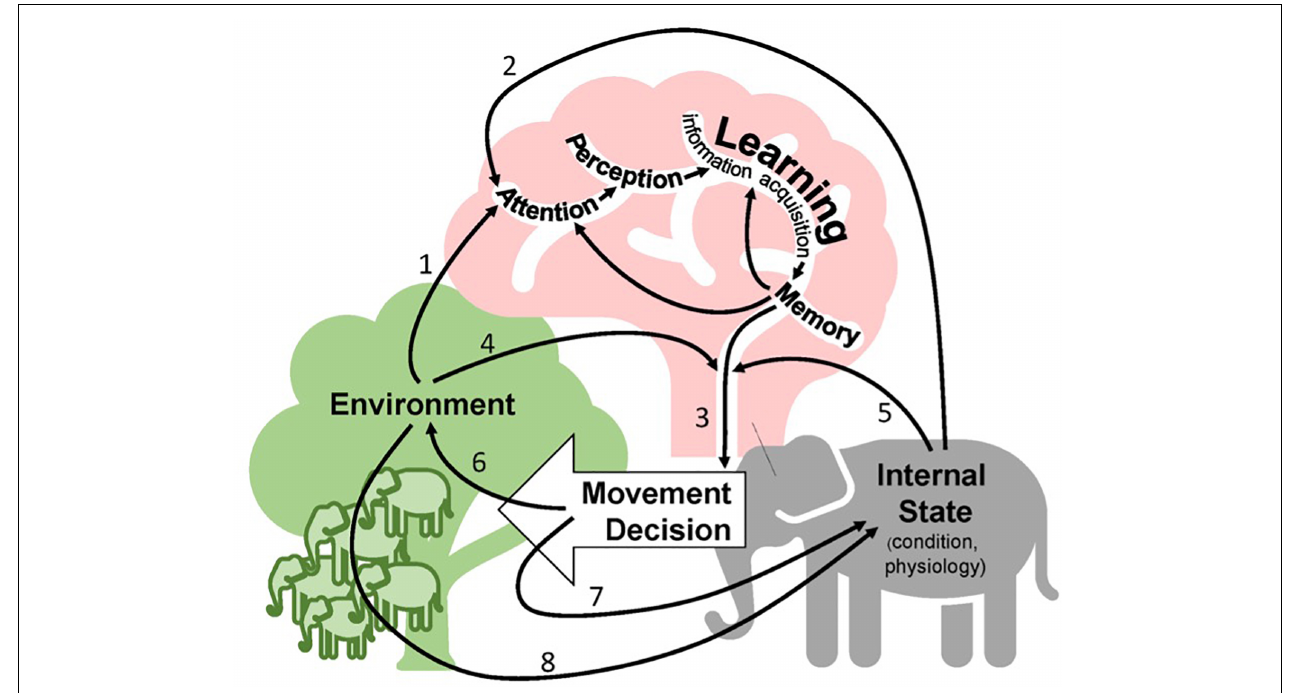
FIGURE 1 | A conceptualization of learning in the context of animal movement. An individual’s environment (green, including social context) and its internal state (gray) can both influence the onset of information gathering via the attention that an individual pays to landscape features (arrows 1 and 2, respectively). As currently understood by psychologists, the information gathering pathway involving attention, perception, learning, and memory appears inside the animal’s brain (pink, unlabeled arrows) ultimately providing input to a movement decision (arrow 3). Both the individual’s environment (arrow 4) and its internal state (arrow 5) can then shape and modify the link between memory and movement. The movement decision has ramifications for the environment (arrow 6) and for the internal state (arrow 7). Lastly, the environment can alter an individual’s internal state directly (arrow 8) without invoking information gathering and memory, often via social